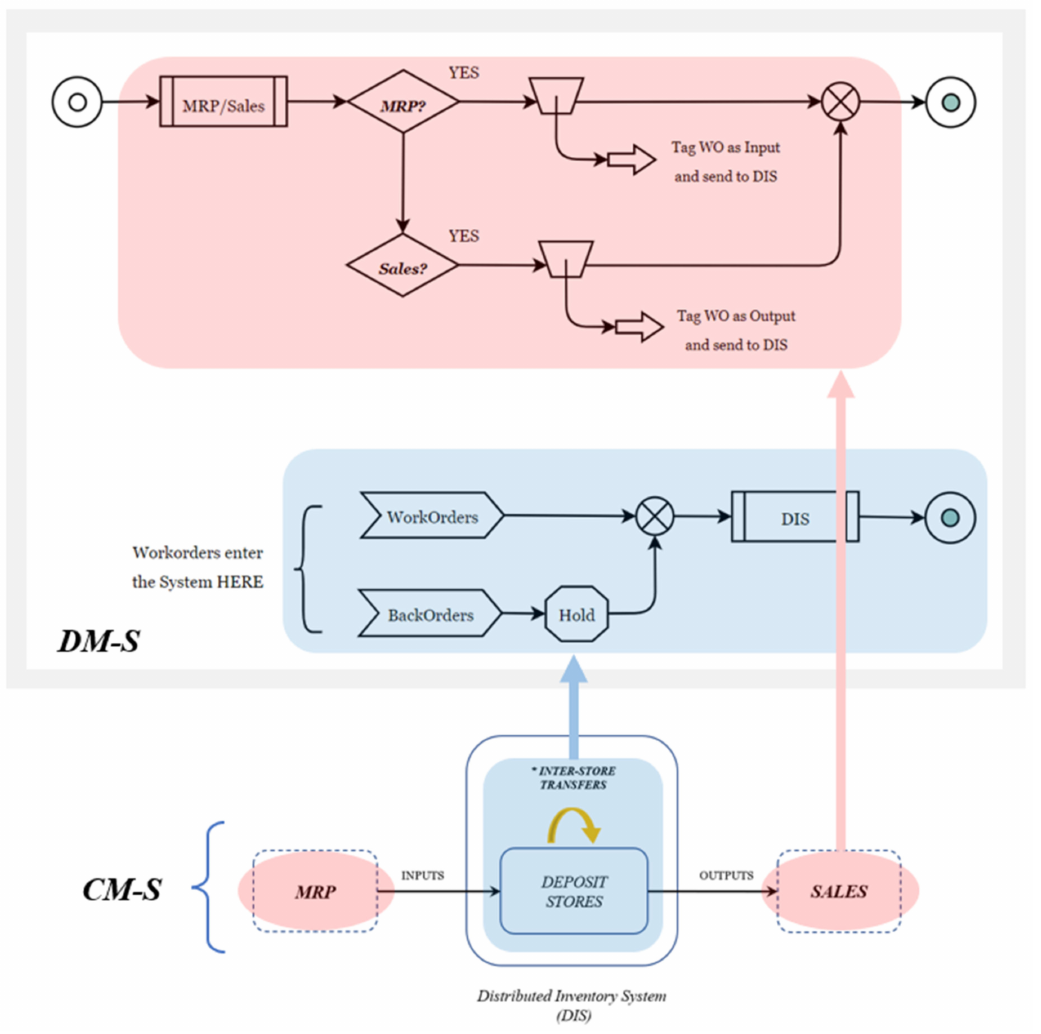
Figure 20. Conversion from CM-S (detailed in Figure 18) to Design Model–Strategic level (DM-S). System elements highlighted in blue, environmental actors in